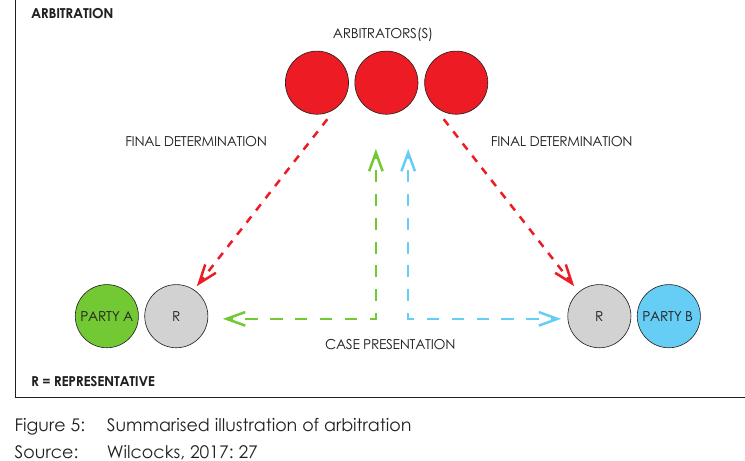
Figure 5: Summarised illustration of arbitration